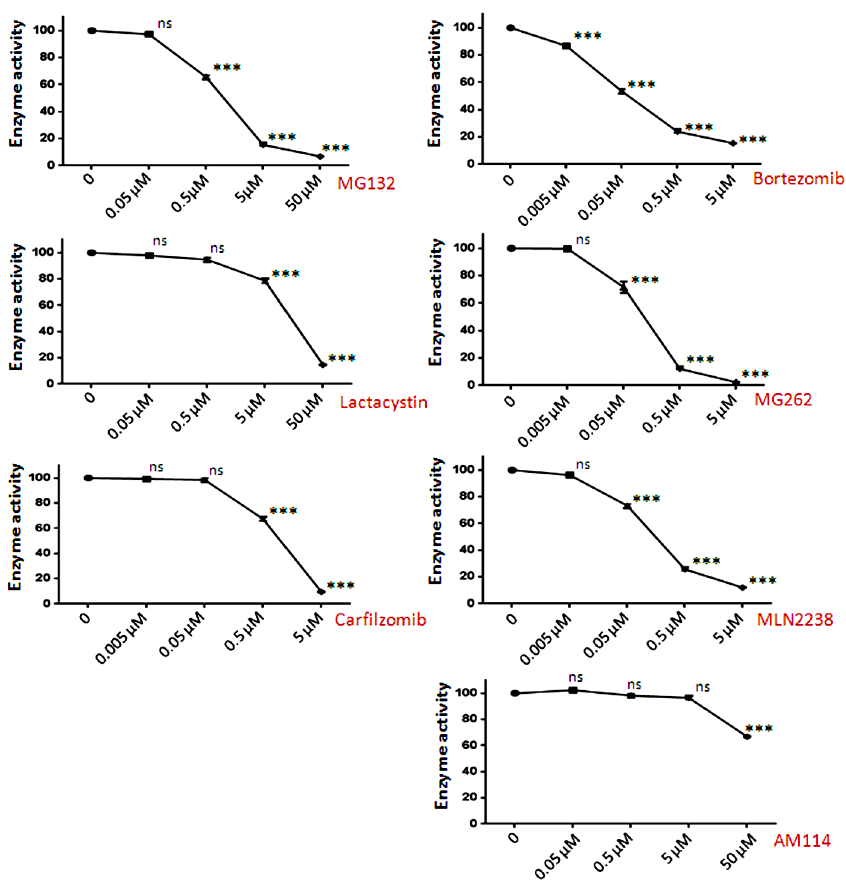
Figure 2. Inhibition of proteasome activity in HEK293T cells with various proteasome inhibitors. HEK293T cell extract was treated with increasing concentrations of the indicated compound for 30 minutes, followed by the addition of substrate Suc-Leu-Leu-Val-Tyr-AMC and incubation for 1 hour at room temperature. Enzyme activity was determined by fluorescence measurement of AMC. The resulting activity is expressed as percent enzyme activity relative to the control reaction without inhibitor. The error bars show standard error of mean (n=3); points without error bars had error ranges smaller than the symbol size. Statistical analysis was performed using Student’s t-test: ***, p # 0.001; ns, no significant difference (p . 0.05) versus the control without inhibitor.